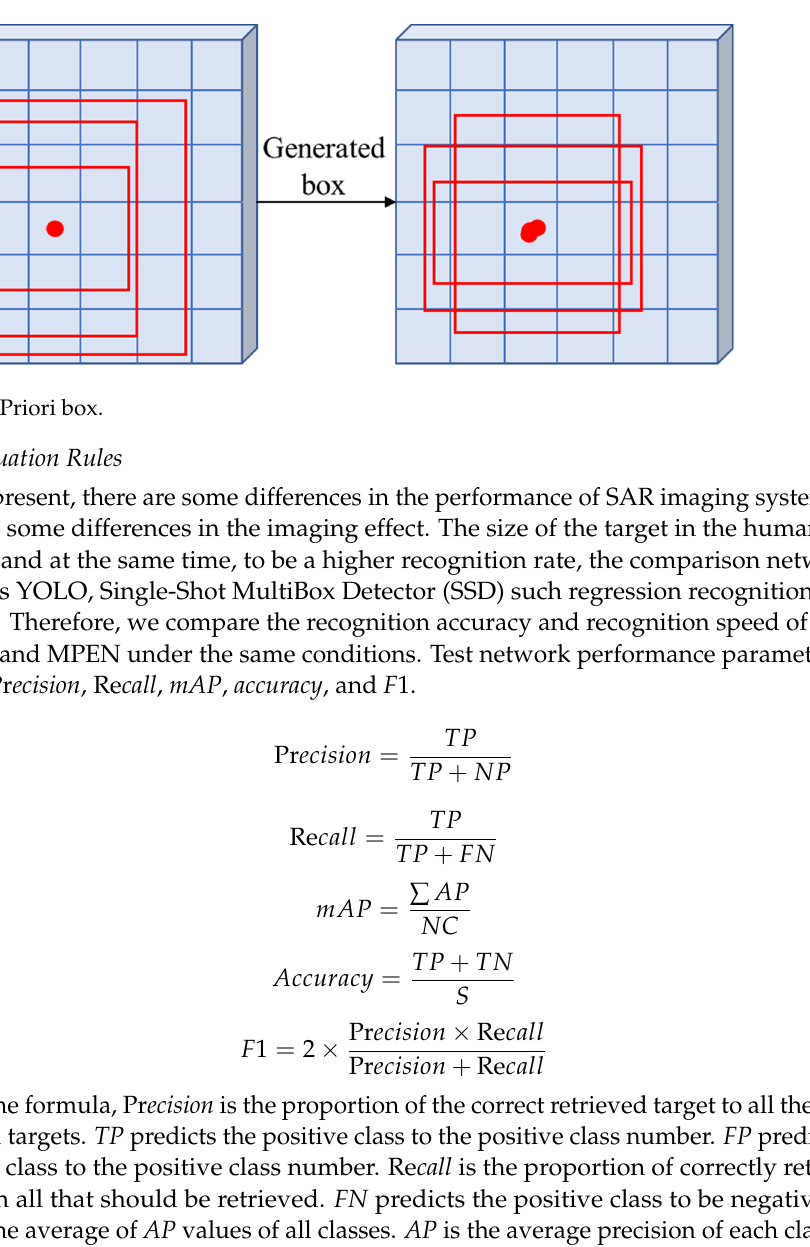
10 of 19 Figure 8. Residual block. (The black box is the original residual block, and the red box is the modified residual block).